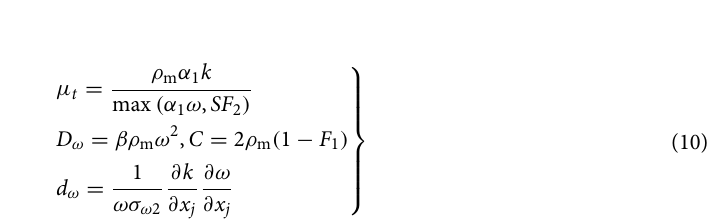
Table 3. Specific parameters of the main measuring